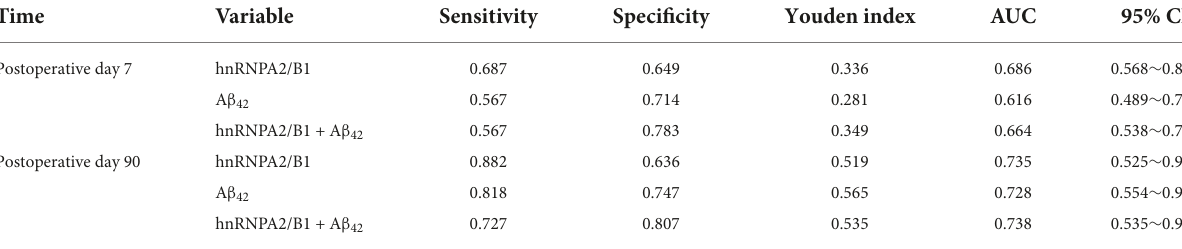
TABLE 4 ROC curve analysis results of plasma hnRNPA2/B1 and A β 42 levels.